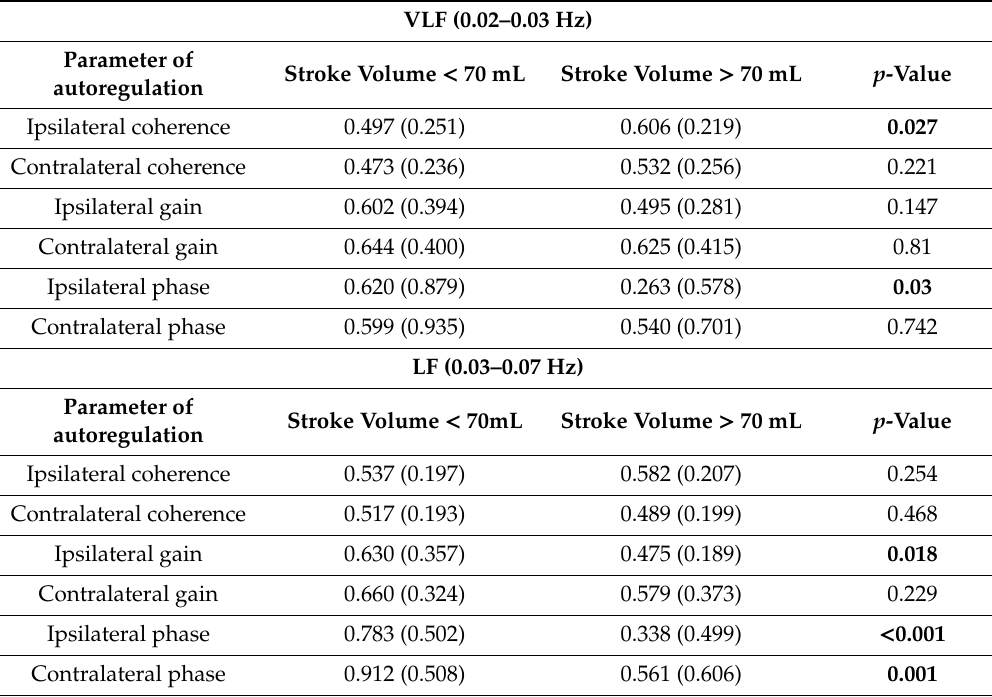
Table 2. Infarct size vs. cerebral autoregulation parameters, as a mean (SD), across all time